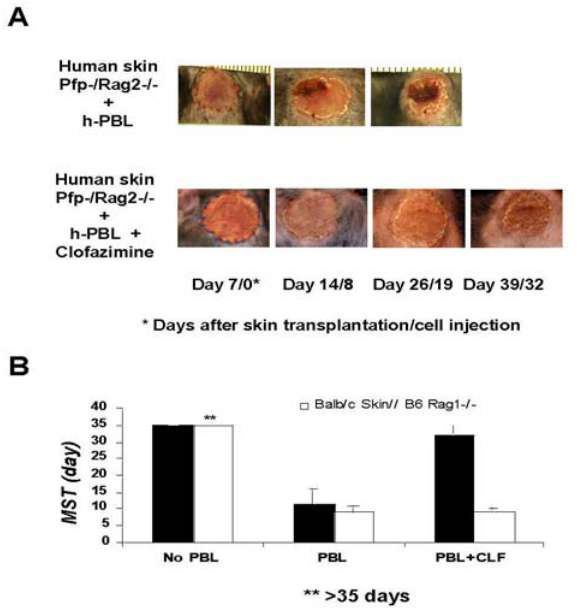
Figure 6. Clofazimine inhibits human T cell-mediated skin graft rejection in immunodeficient mice. ( A ) Representative skin grafts at different days post-transplantation. Human foreskin was transplanted onto Pfp/Rag2 2 / 2 mice. 1.0 6 10 8 human peripheral blood lympho- cytes (PBL) were adoptively transferred into each animal at Day 7 post- transplantation. Administration of clofazimine or carrier control (olive oil) was also initiated at Day 7. * Days after skin transplantation/cell transfer. ( B ) Effect of clofazimine on the mean survival time of transplanted human (n=5) and mouse (n=4) skin grafts. The mouse skin transplantation was performed using Balb/c mice as skin donors, B6 Rag1 2 / 2 mice as recipients and PBL from B6 for adoptive transfer.